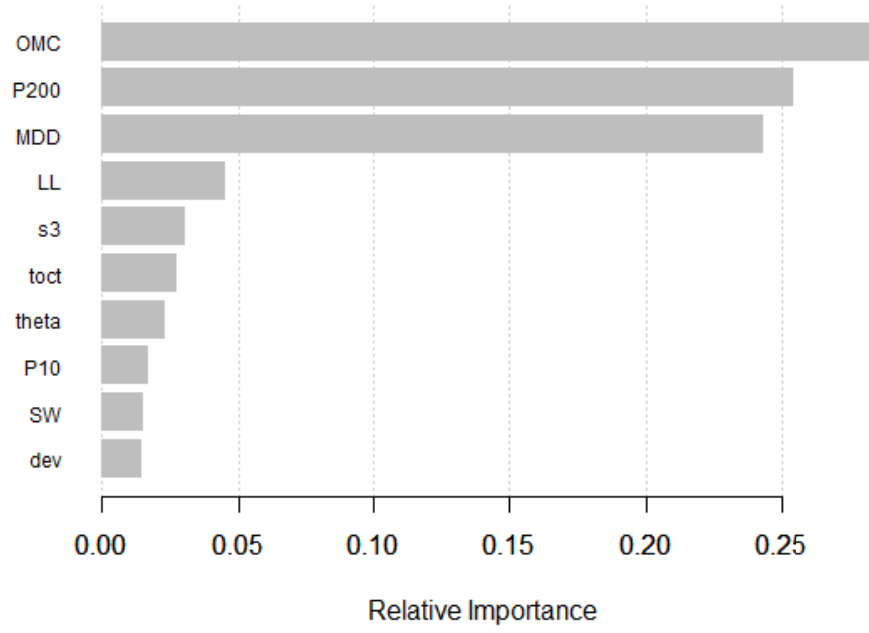
Figure 10. Relative importance of top 10 variables (the XGBoost model).